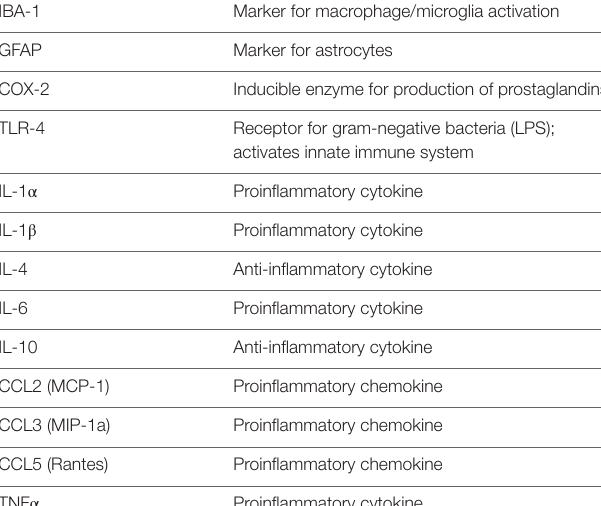
Table 3 | Function of immune markers from Figures 4 and 5. IBA-1 Marker for macrophage/microglia